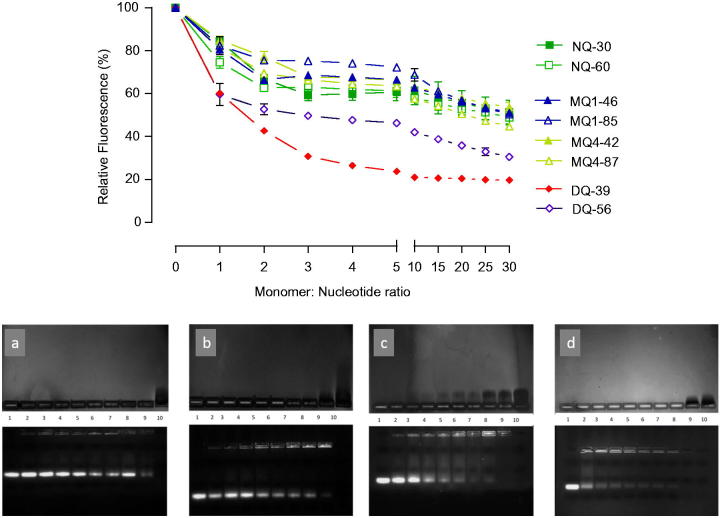
siRNA complexation by piperazine substituted chitosans. (A) EtBr displacement assays of piperazine substituted chitosans with siRNA. Polymers and EtBr containing siRNA solutions in 10 mM Tris-HCl buffer pH 7.4 mixed at specified at monomeric unit: nucleotide ratio; fluorescence level expressed as a% of the initial relative fluorescence of the EtBr siRNA complex (n = 3). (B) Agarose gel electrophoresis. The upper image shows the migration of free polymer, and the lower image shows the migration of free siRNA. The bands were visualized as described in the Methods section. Lane 1: siRNA control; lanes 2–9: polymer:siRNA complexes at ratios 0.25, 0.5, 0.75, 1.0, 1.25, 1.5, 2.0, and 5.0 to 1; lane 10: polymer control. Polymers: gel a shows MQ1-46; b: MQ4-42; c: NQ30; and d: DQ39.